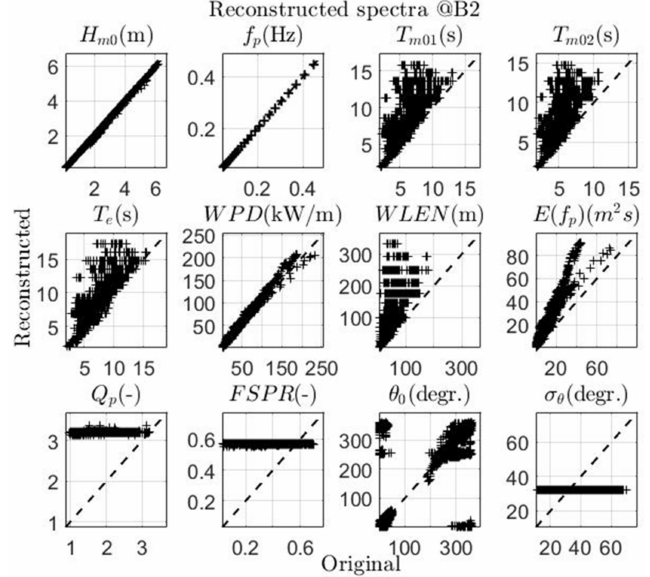
Figure 10. Scatter plots for KPs obtained from the original and the TMA–Mitsuyasu reconstructed spectra at check point